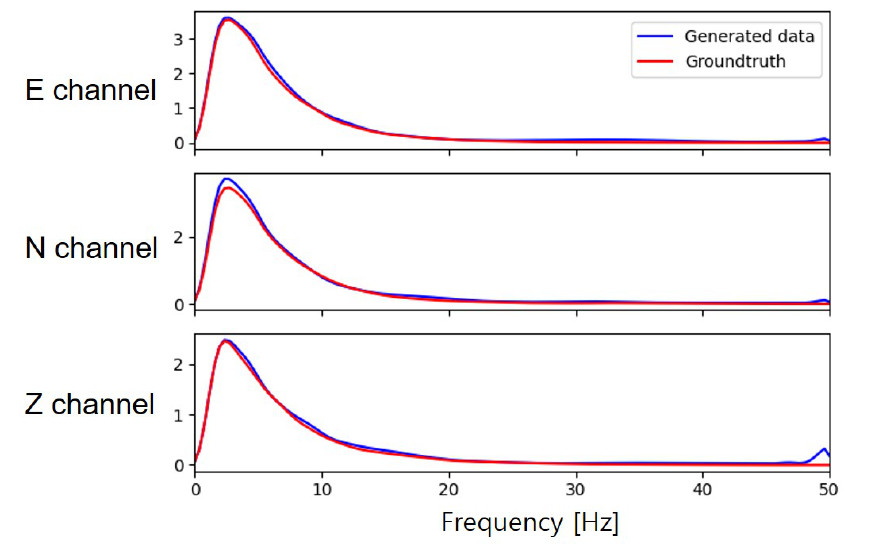
Figure 11. The spectrum comparison between the real dataset and synthetic